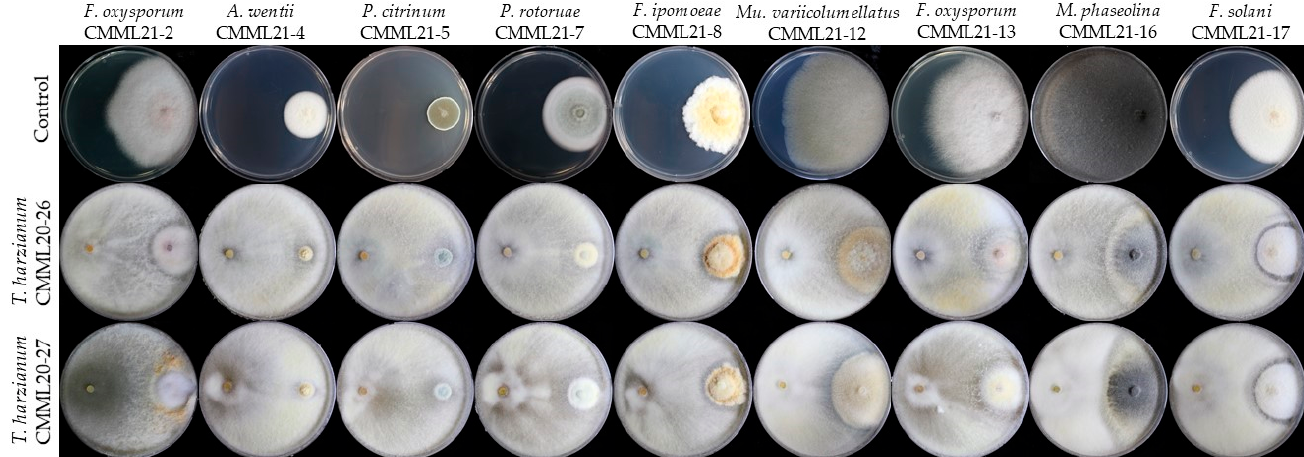
Figure 11. Representative photographs of in vitro dual culture assay for mycelial growth inhibition of 8 different pathogenic species isolated from sweet potato storage roots by Trichoderma harzianum strains CMML20 ‐ 26 and CMML20 ‐ 27.